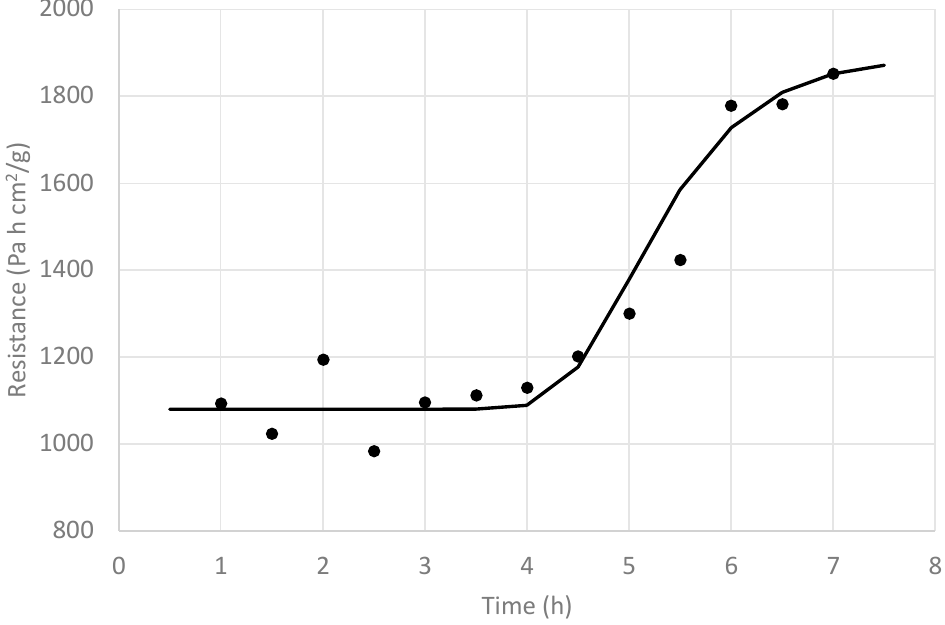
Figure 14. Values of (R T ) along the freeze-drying time (•) and its corresponding tendency line ( — ) of nine CO 2 laser microperforations treated blueberries.